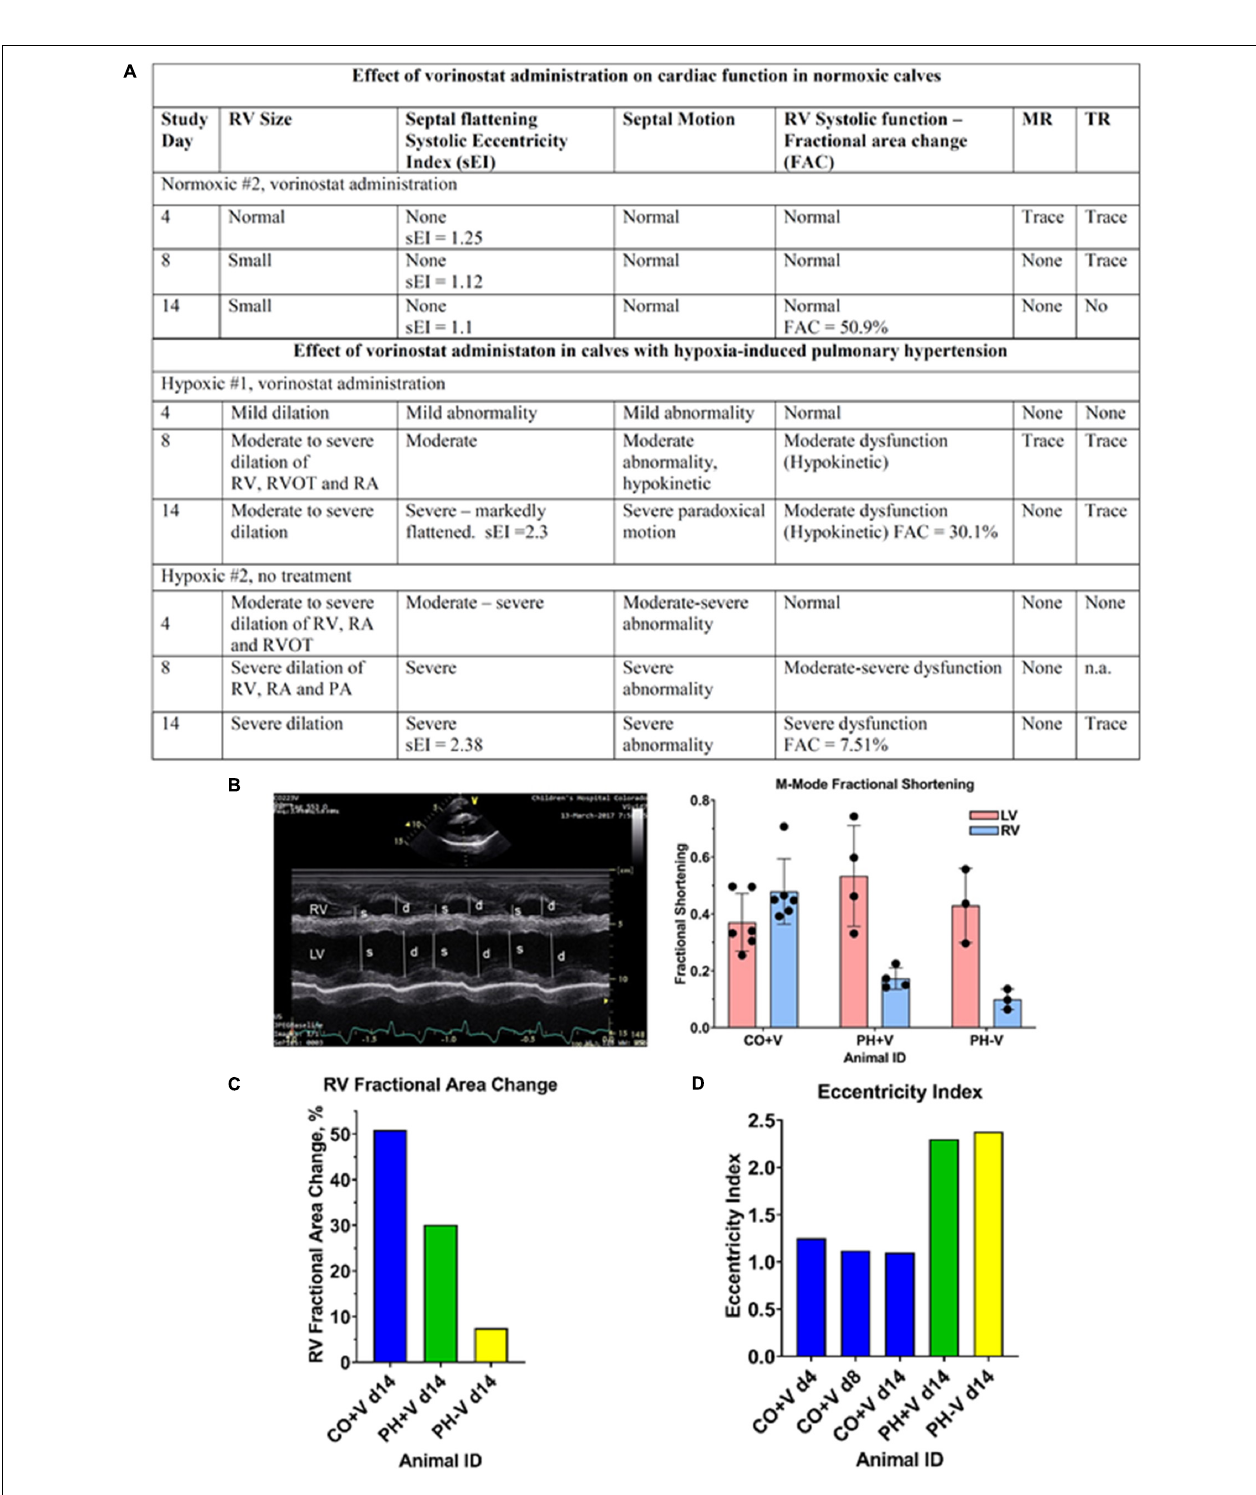
FIGURE 2 | Summary of qualitative and quantitative echo assessments. Echo records were independently evaluated by qualified sonographers as described in section “Materials and Methods.” (A) Summary of qualitative echo findings. (B) Quantitation of RV and LV fractional shortening. Left panel, representative M-mode tracing, showing RV and LV chamber dimensions at systole (s) and diastole (d). Right panel, quantitation of RV fractional shortening. Each dot represents the average of fractional shortening values determined over 3–4 cardiac cycles in a single M-mode trace; multiple traces were obtained for each condition. (C) Quantitation of RV Fractional Area Change (FAC). FAC was determined from cinematic echo recordings over multiple cardiac cycles for each condition. (D) Quantitation of Eccentricity Index (EI). EI was determined from cinematic echo recordings over multiple cardiac cycles for each condition.